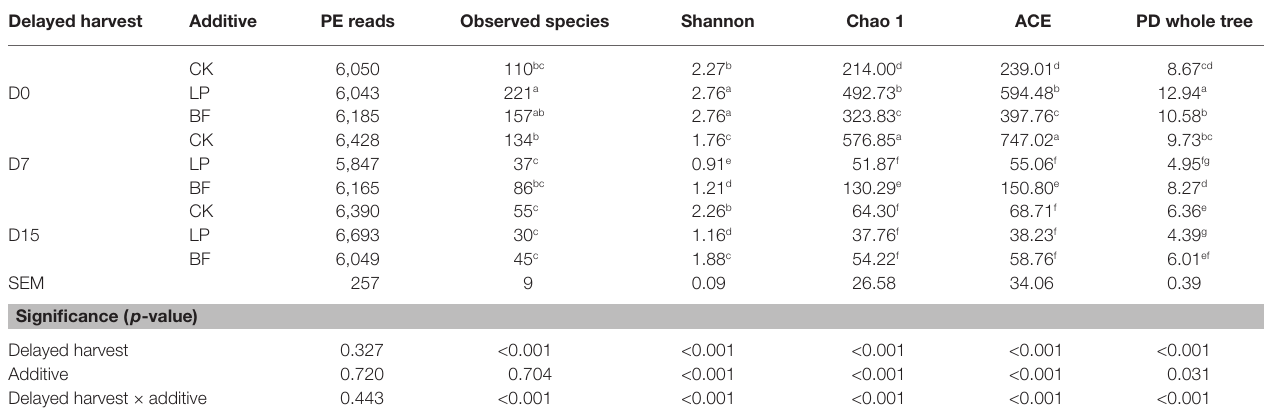
SEM, standard of error mean. D0-15 indicated stay-green corn stalks after 0, 7, and 15 days of ear harvest. Different letters within a column are significantly different (p <